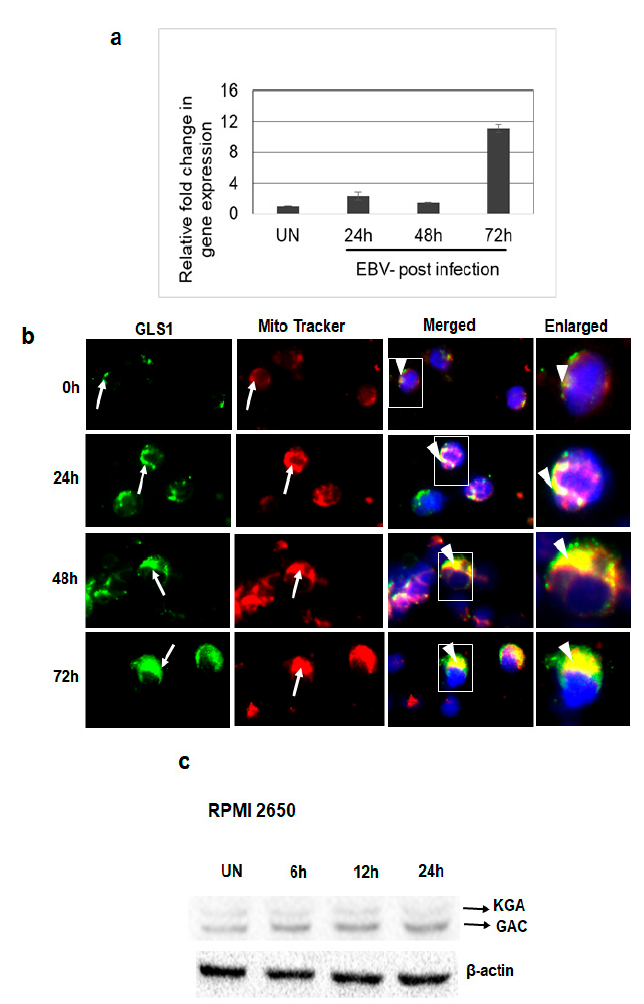
Figure 4. GLS1 expression in EBV-infected PBMCs in vitro. ( a ) and ( b ) PBMCs were left uninfected or infected with ~20 MOI of EBV for 24 h, 48 h, and 72 h at 37 °C. ( a ) Total RNA was extracted from uninfected and EBV-infected PBMCs and the expression of GLS1 was determined by real-time RT-PCR. GAPDH was used as an internal control. The fold change was calculated and compared to the uninfected control. Error bars represent the mean ± SD of two independent experiments. ( b ) Uninfected or EBV-infected PBMCs were incubated for 45 min with MitroTracker (red) at 37 °C and stained using KGA/GAC isoform-specific antibody, followed by secondary antibody conjugated to Alexa Flour 488 (green). Nuclei were stained with DAPI (blue). Arrows indicate KGA/GAC and mitochondrial staining, and arrow heads indicate their colocalization with the mitochondrial marker. Magnification ×60. Boxed areas are enlarged in the rightmost panel. ( c ) RPMI 2650 cells were left uninfected (UN) or infected with EBV for 6 h, 12 h, and 24 h. Cell lysates were Western blotted using KGA/GAC antibody. β -actin was used as loading control.